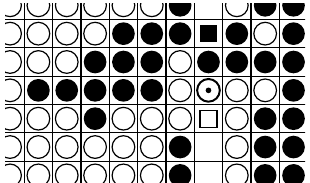
Figure 61. B-timer with a focus.